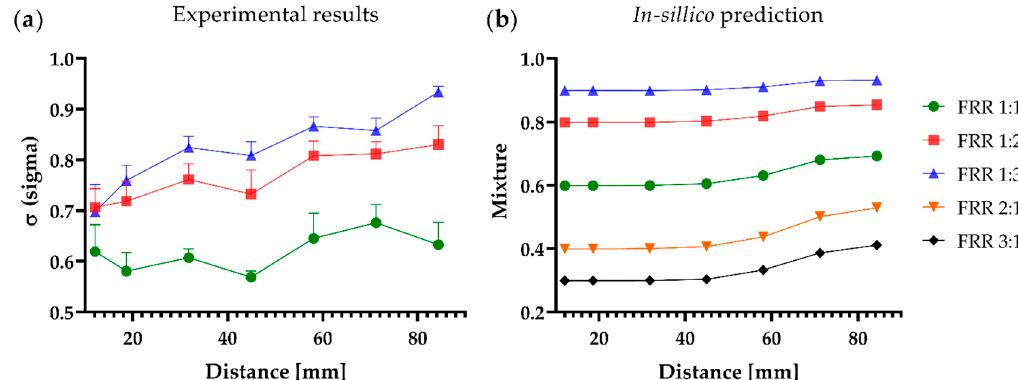
Figure 6. Mixture evaluation at different channel distances from the inlets. ( a ) Mixture quality measured from images; ( b ) Mixture quality predicted by mixture model results (passive mixing).